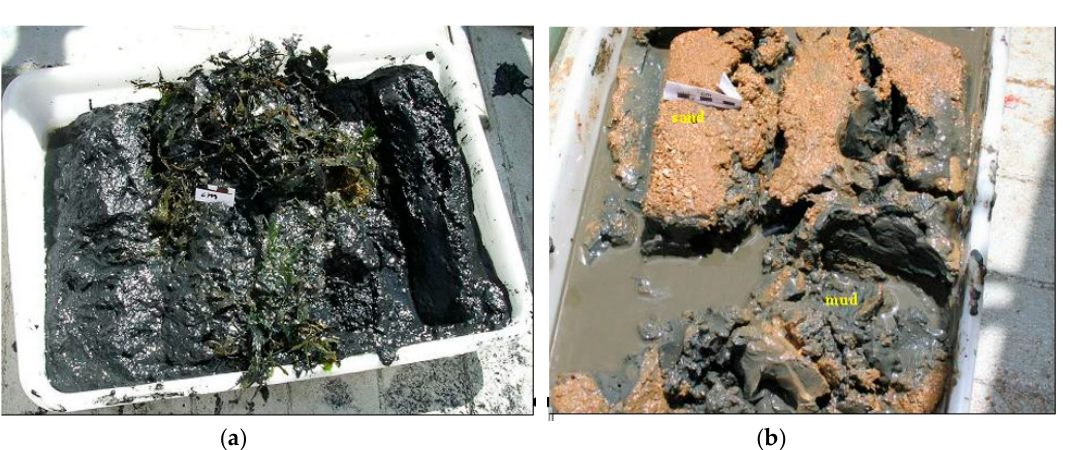
Figure 4. Sediments sampled from different stations: ( a ) Mud, which constituted the bottom part of the sample, looked black, whereas ( b ) the clearer sand stayed on the